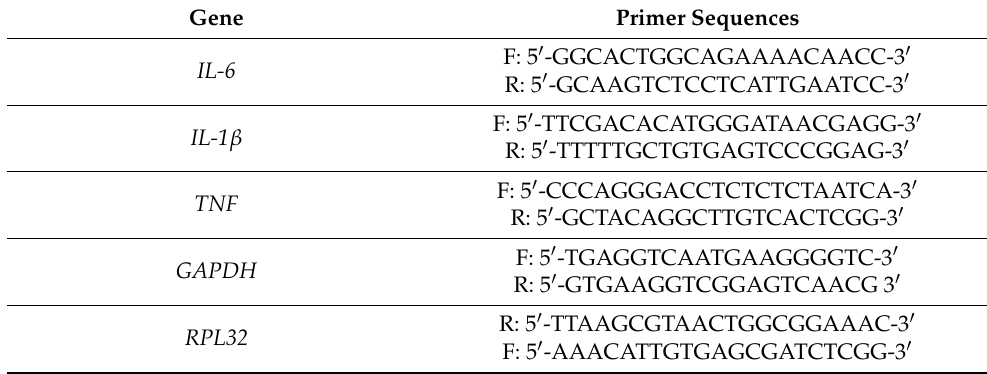
Table 3. List of primers designed for